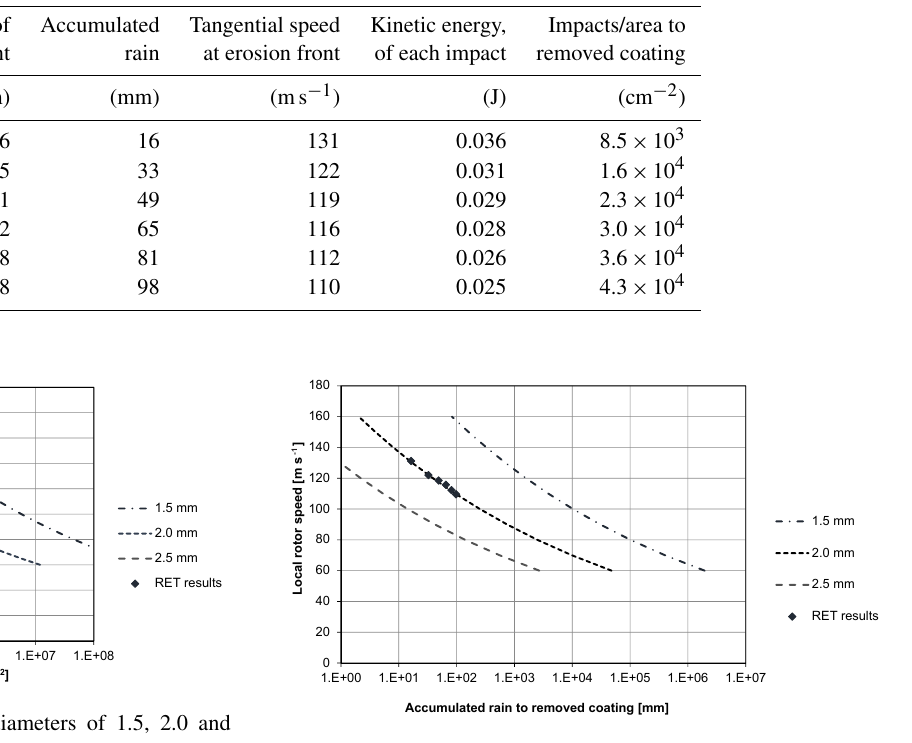
tion of rotor speed for droplet diameters of 1.5, 2.0 and 2.5mm.